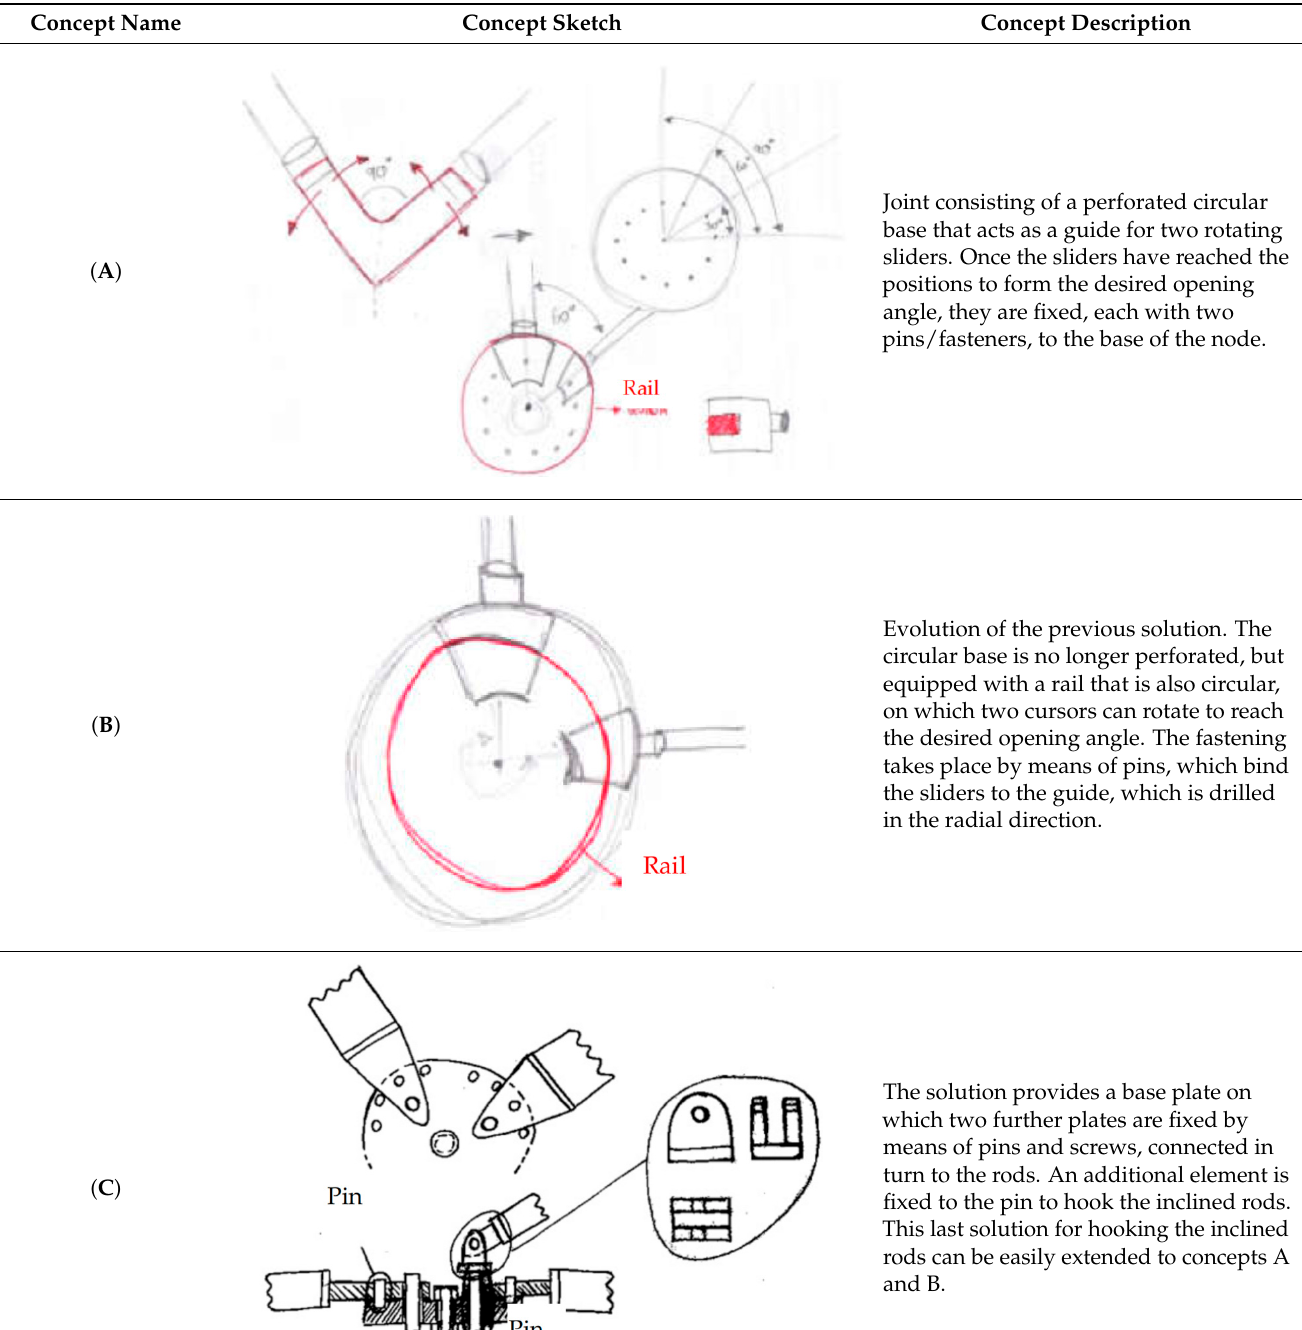
Table 3. Concepts conceived starting with the structure shown in Figure 6.